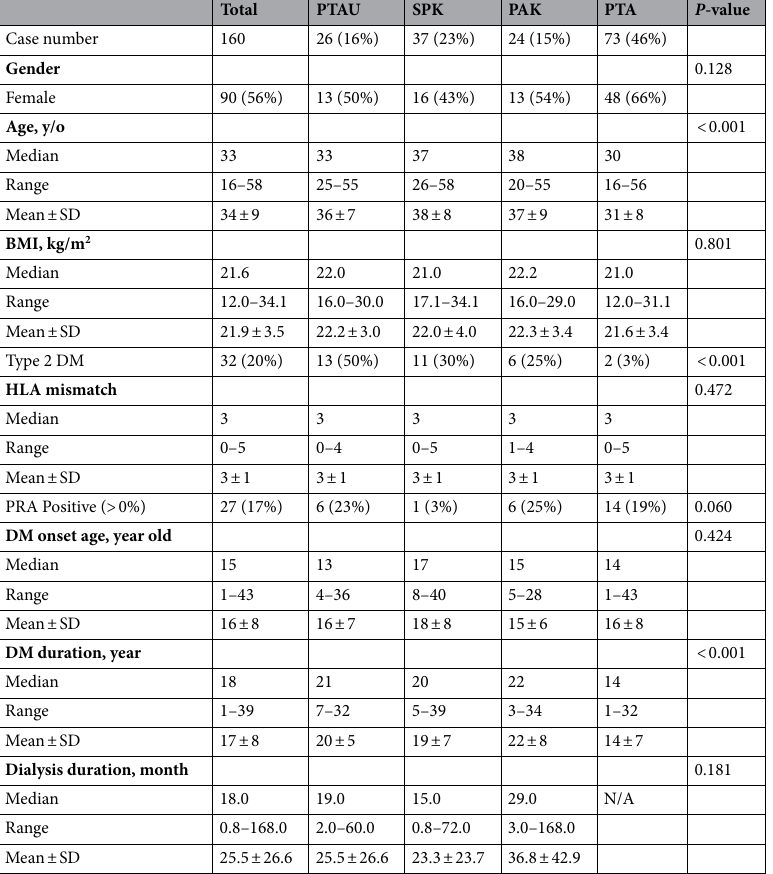
Table 2. Demographics for diabetic patients undergoing pancreas transplant. PTAU pancreas transplant alone in uremic patients, SPK simultaneous pancreas and kidney transplant, PTA pancreas transplant alone, PAK pancreas after kidney transplant, BMI body mass index, HLA human leukocyte antigen, PRA panel reactive antibody, DM diabetes mellitus.